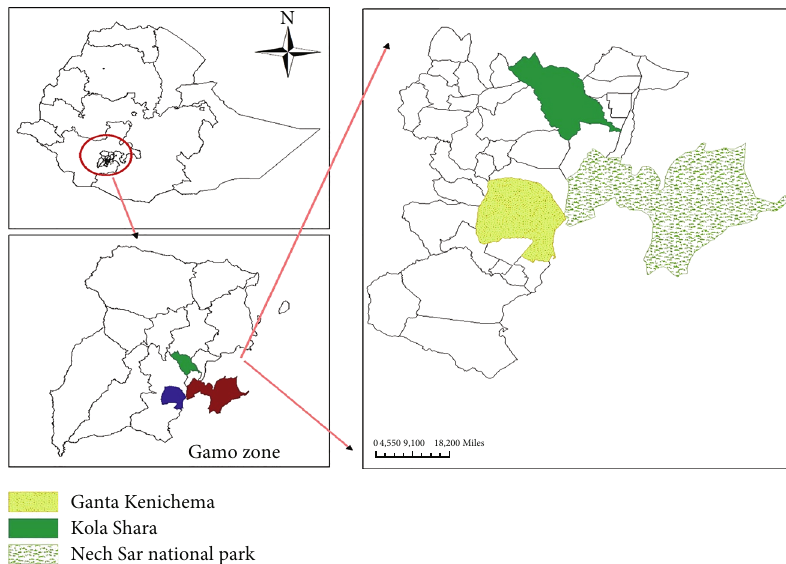
Figure 1: Map of the study